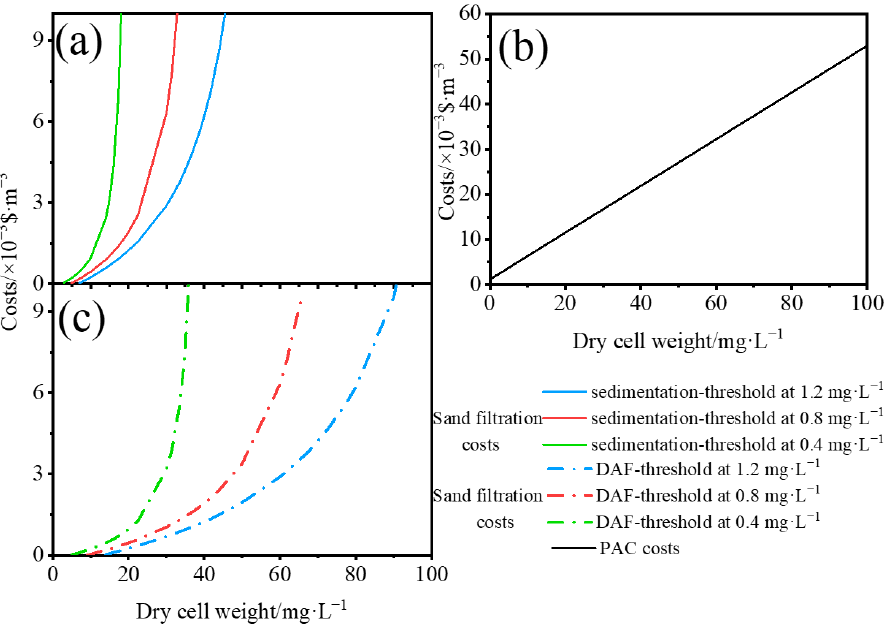
Figure 5. ( a ) Sand filtration costs when using sedimentation under different sand filter effluent thresholds with algae concentrations in raw water, ( b ) PACl costs under different algae concentrations in raw water, ( c ) sand filtration costs when using DAF under different sand filter effluent thresholds with different algae concentrations in raw water.